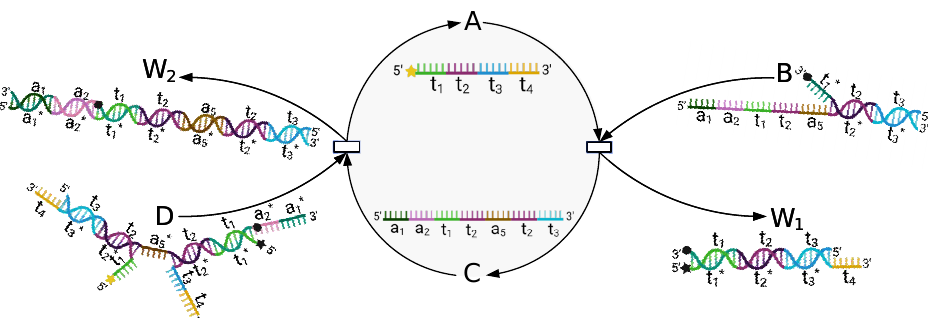
Figure 3. Schematic illustration of the catalytic reaction module, by which the concentration of Species A is extended to twice its original concentration so that Species A can be used to encode the seed